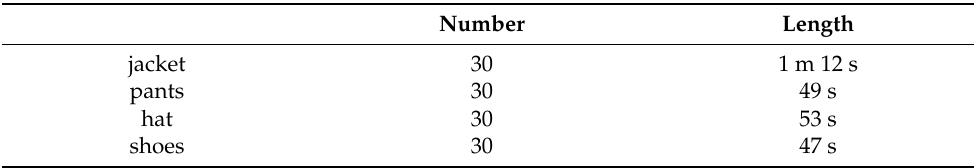
Table 1. Basic parameters of the Clothes Video Dataset. Number Length jacket 30 pants hat 53 s shoes 30 47